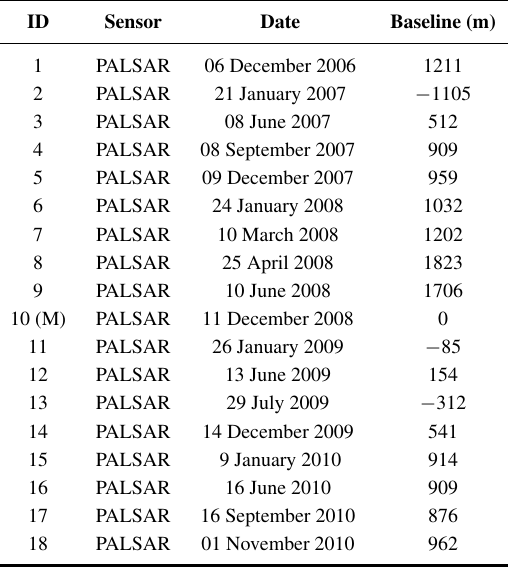
Table A2. SAR satellite data used in this study for the period of 2006 to 2010. M: master